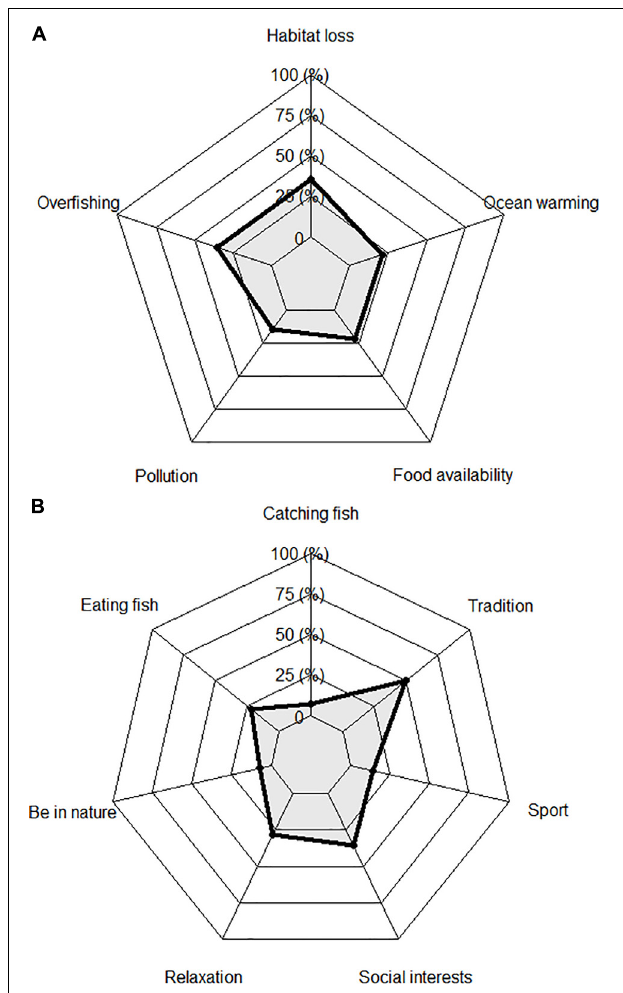
FIGURE 2 | Impacts on ecosystems (A) and individual motivations (B) reported by recreational fishers.